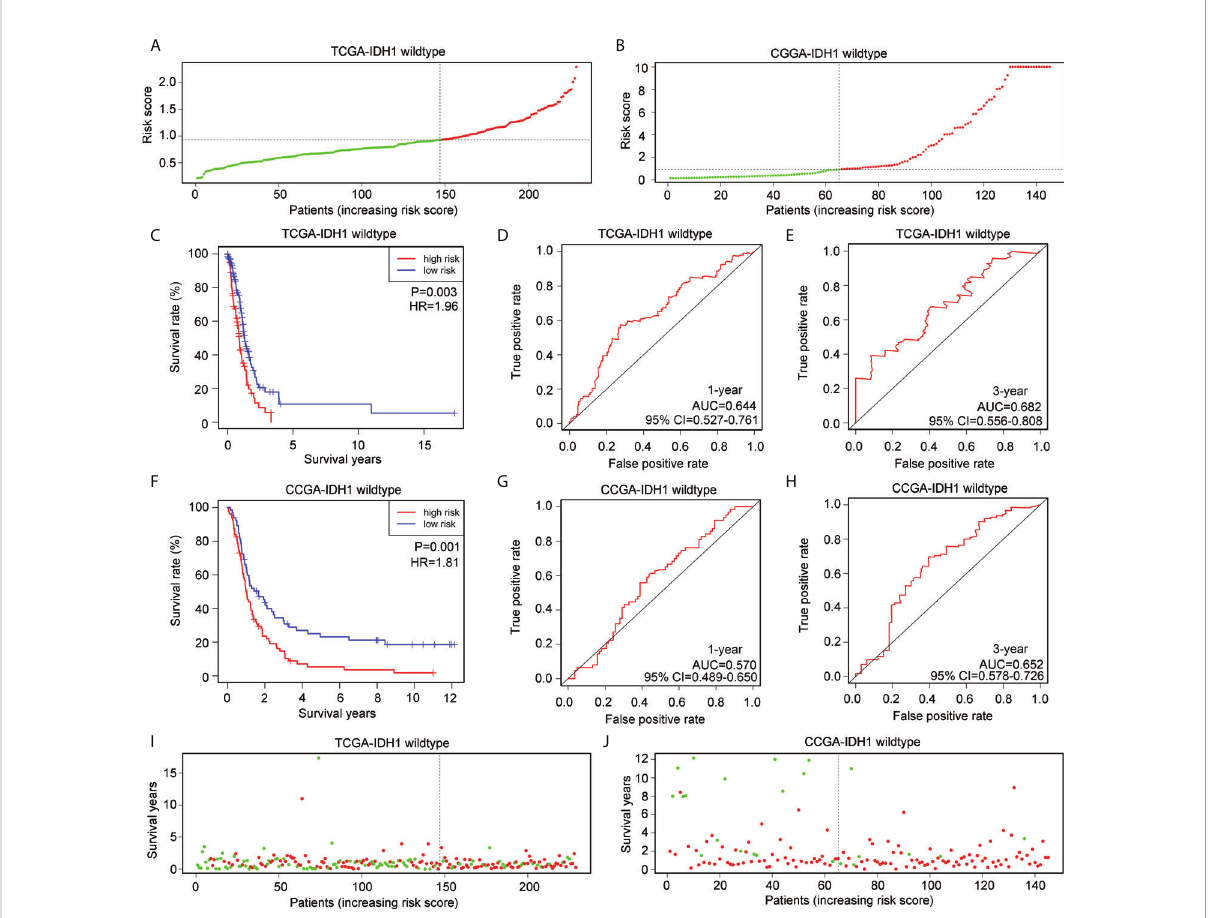
FIGURE 6 Veri fi cation of the applicability of the risk model in wtIDH1-glioma patients in TCGA and CGGA databases. (A, B) wtIDH1-glioma patients in TCGA and CGGA databases were divided into high- and low-risk score groups according to the median of risk scores. (C) The survival difference between high- and low-risk score group wtIDH1-glioma patients in TCGA. (D, E) The diagnostic value of risk model for one- and three-year survival in wtIDH1-glioma patients in TCGA. (F) The survival difference between high- and low-risk score group wtIDH1-glioma patients in CGGA. (G, H) The diagnostic value of the risk model for one- and three-year survival in wtIDH1-glioma patients in CGGA. (I, J) Death cases in high- and low-risk score group wtIDH1-glioma patients in TCGA and CGGA (Green dots mean alive cases, red dots mean death cases).